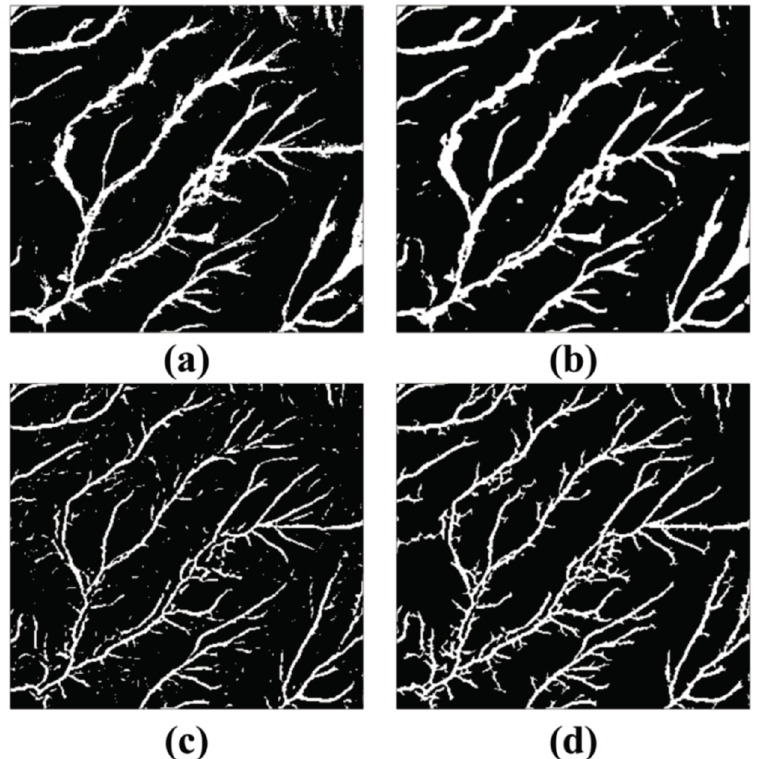
Figure 7. Classified rivers using a global threshold for: ( a ) original image, ( b ) pre-processed image, ( c ) image after Gabor filtering, and ( d ) image after path opening.